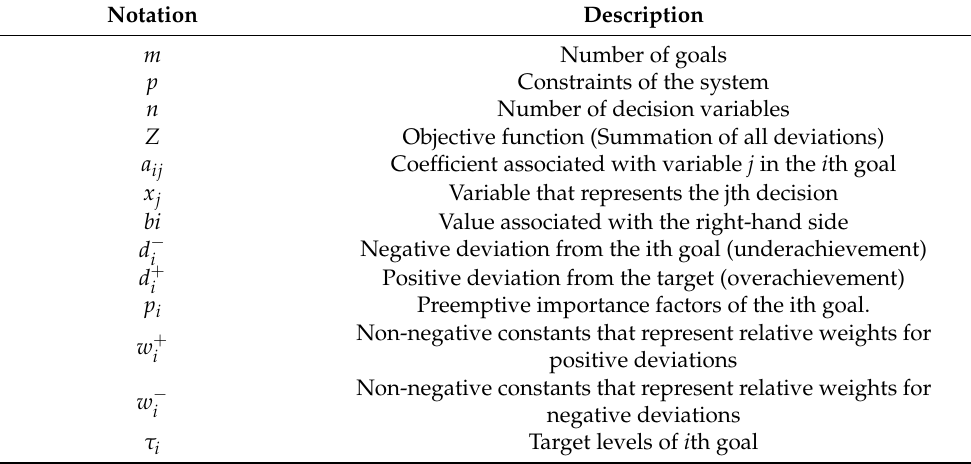
Table 1. Modeling